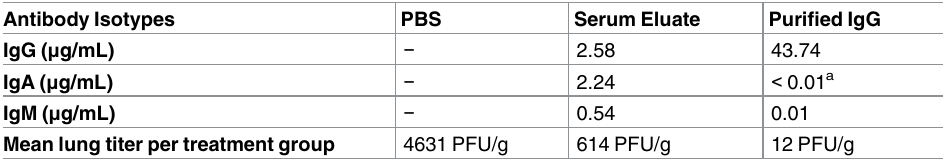
Table 1. Summary of antibody passive transfer experiment. Antibody